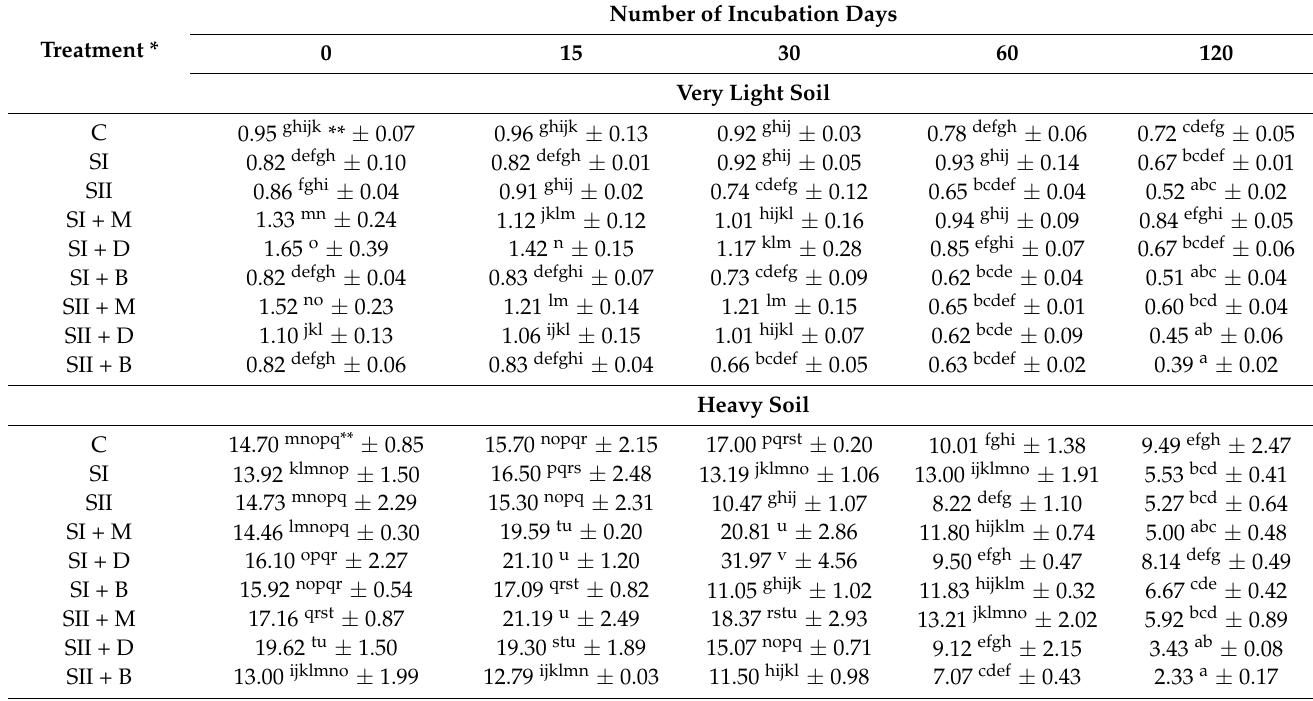
Table 6. Dehydrogenase activity in very light and heavy soil throughout the incubation experiment ( µ g TPF/g d.m./24h ±